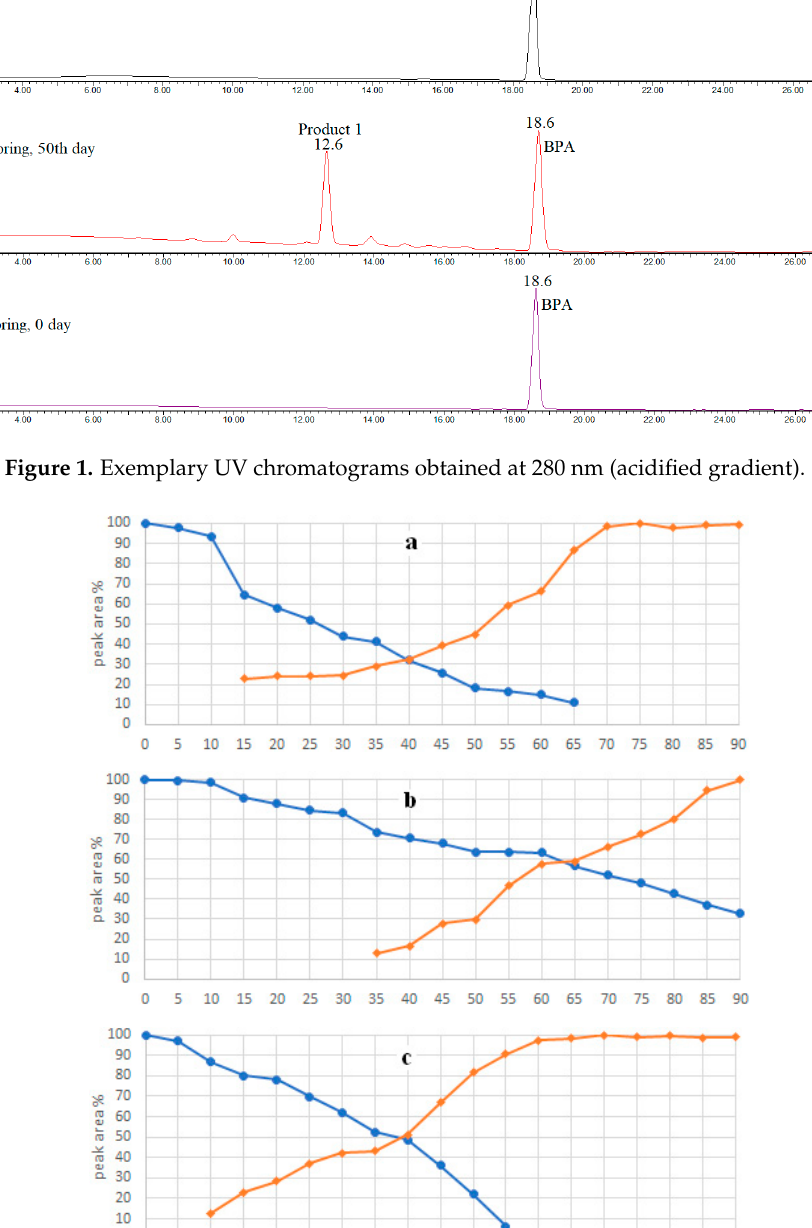
Figure 2. Exemplary breakdown plots of chromatographic peak areas (UV chromatogram at 280 nm) against days of biodegradation test bisphenol A (BPA) (BPA was added to water samples at 10 mg/L on day 0, BPA, Product 1): ( a ) Niepruszewo lake, summer; ( b ) Niepruszewo lake, spring; and ( c ) Warta river, spring. As clearly seen from Figure 2, the rate of BPA biodegradation strongly depends on the source of environmental water taken for the test. However, in each test, the biodegra- dation product characterized with a retention time of 12.6 min was not further degraded. HPLC/ESI-MS analyses have indicated that molecular mass of the biodegradation product at the retention time of 12.6 min is 244 (ion [M-H] − at m/z 243). In order to unam- biguously determine the structure of the biodegradation product, we performed the HPLC/UV/ESI-MS analysis using non-acidified gradient, since it allowed obtaining much